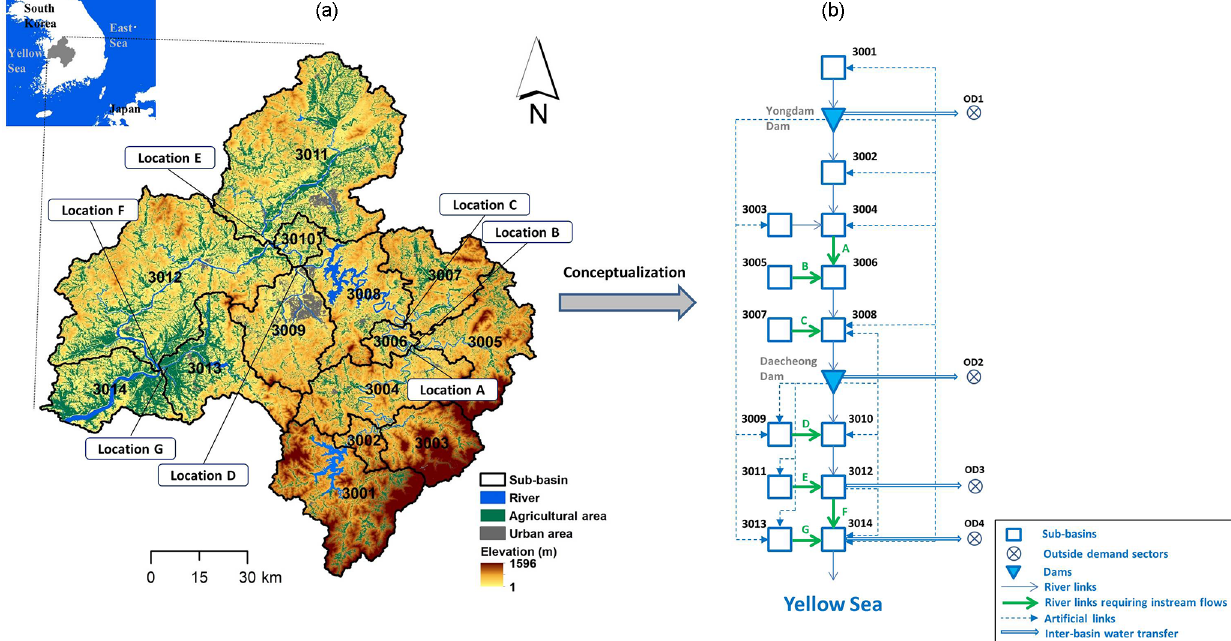
Figure 1. Layout of the Geum River basins (a) and the simplified node-and-link network for modeling water allocations (b) .